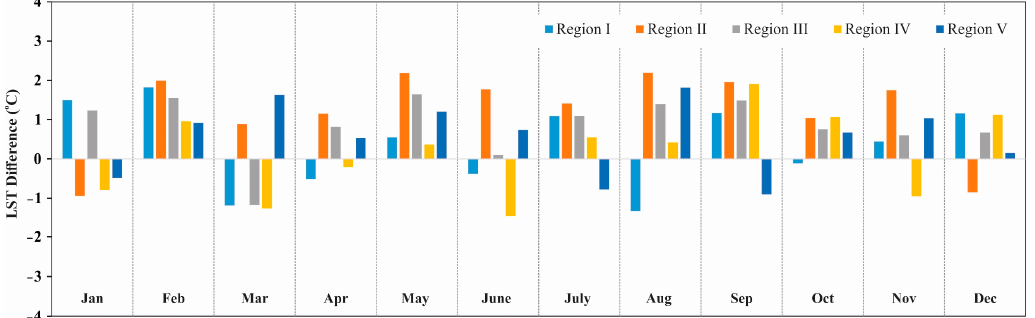
Figure 10. The monthly mean variations of LST over different sub-regions of Pakistan during 2018 to 2021.